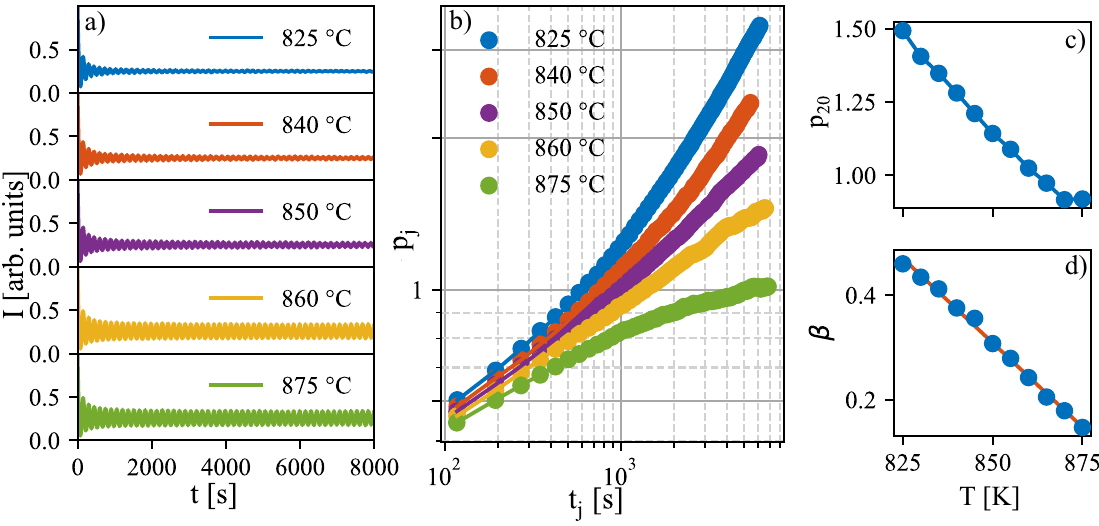
Figure 5. ( a ) Simulated AB intensities for simulations with increasing temperature for chosen temperatures T = ◦ 825, 840, 850, 860, and 875 C. ( b ) The relative widths of individual level coverages fitted by tanh profile. ( c ) The characteristic profile width p 20 and ( d ) the evolution of β with